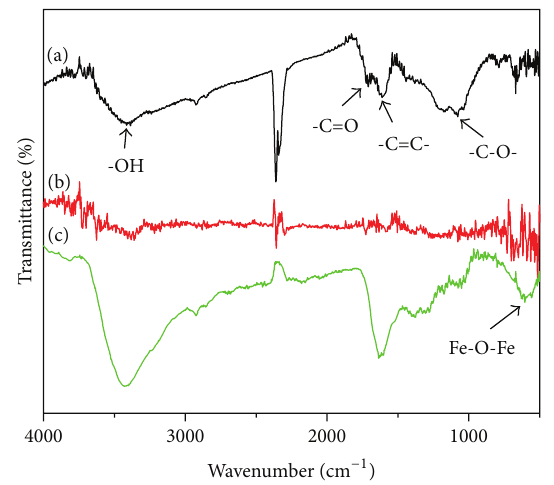
Figure 3: FT-IR spectra of GO (a), rGO (b), and Fe 3 O 4 /rGO (c).